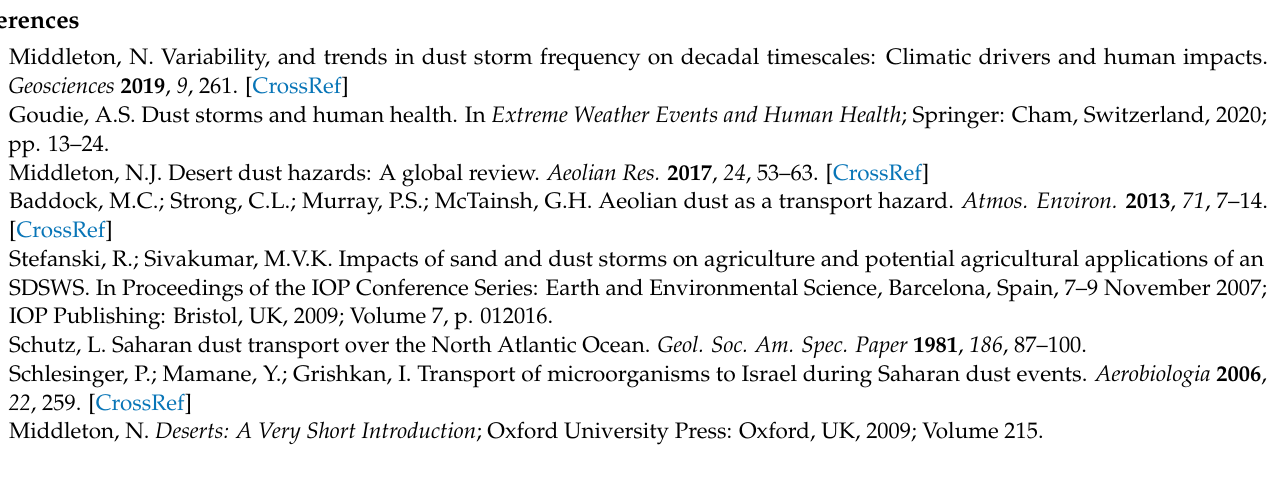
Figure A5. Same as Figure 10 but for 00 UTC 30 October 2017.